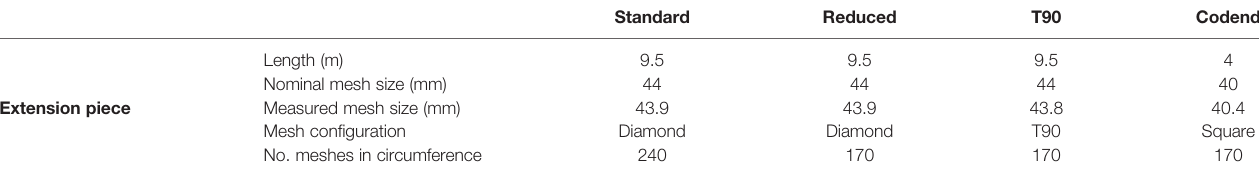
TABLE 1 | Technical features of the extension piece plus codend of the three net con fi gurations (Standard, Reduced, T90) tested in the